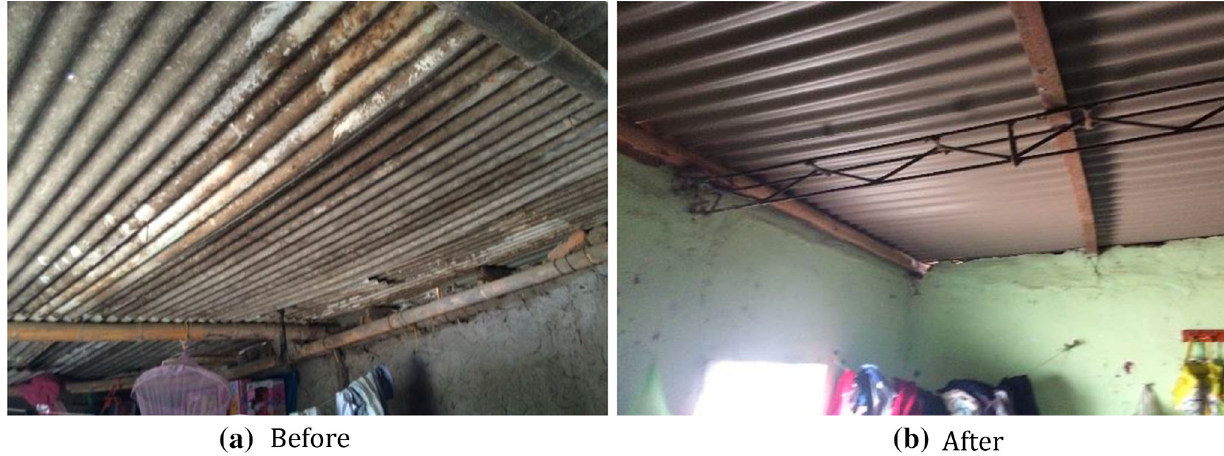
Fig. 5 Before and after pictures of the kit provision. Note : The pictures correspond to a house in the Horco´n I community, Picsi District. The roof was reinforced in the bedroom, living room, and dining room. Source FbF